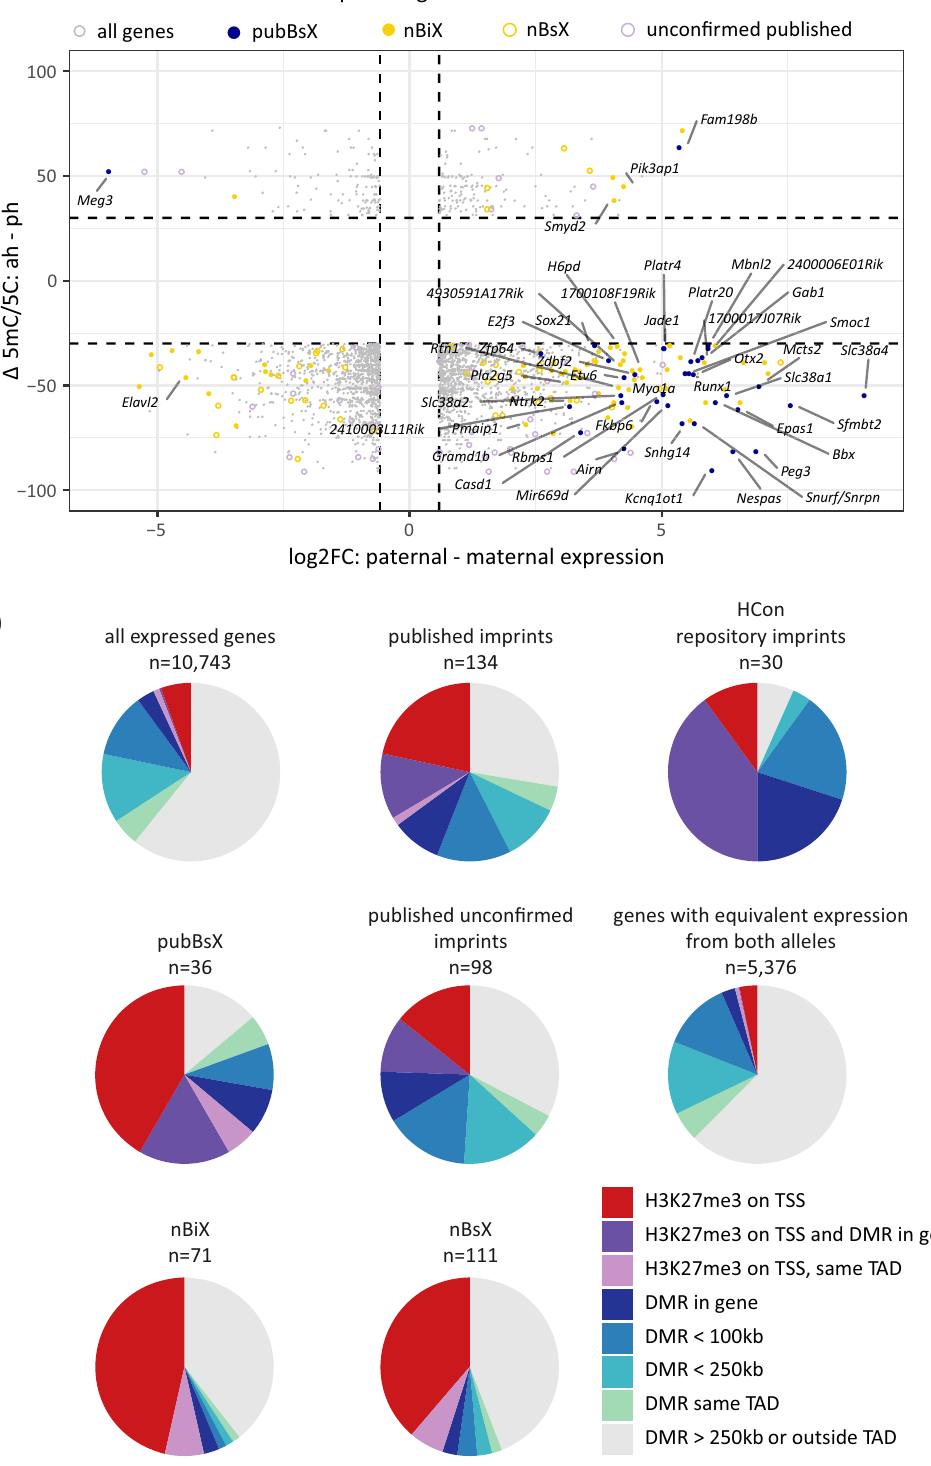
Fig. 3 Intersecting DMRs and allele-speci fi c H3K27me3 with parental-allele-speci fi c gene expression. a Comparison of differential DNA methylation in uniparental blastocysts ( y -axis) and parent-of-origin-speci fi c gene expression ( x -axis). Published and novel imprinted genes (nBiX and nBsX) are indicated in colour and other genes in grey. Each dot represents one gene associated with its closest DMR. Selected genes are labelled. b Pie charts representing all 10,743 genes whose expression was robustly detected, 134 published imprinted genes with expression data, 30 HCon repository imprints, 36 pubBsX genes, 98 published uncon fi rmed imprinted genes, 5,376 genes that are signi fi cantly biallelically expressed in blastocysts, 71 nBiX and 111 nBsX genes. Each chart indicates associations to different genomic features (DMRs and/or parent-of-origin-speci fi c H3K27me3 on TSS). Distances from these genes to their nearest DMR are colour coded. Further colour codes indicate the presence of allele-speci fi c H3K27me3 on the gene promoter (TSS ± 5 kb) or association with a DMR in the same topologically associating domain (TAD), independent of genomic distance. Source data are provided as Source Data fi les. NATURE COMMUNICATIONS| (2021) 12:3804